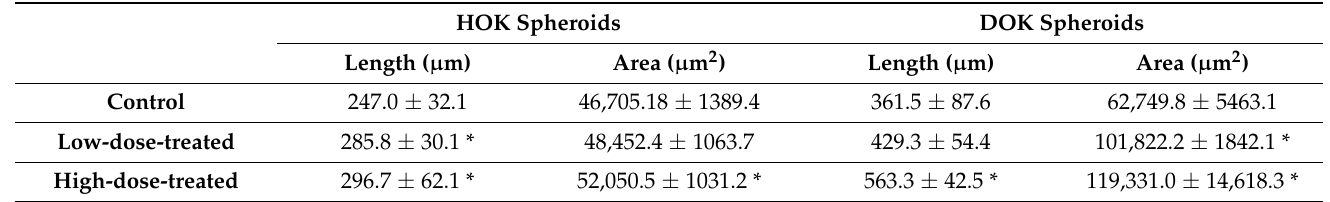
Figure 1. Size, viability, and invasiveness of HOK spheroids treated with the carcinogen 4NQO. ( a ) Representative images of HOK spheroids on days 1–8, treated daily for 90 min with low (0.36 µM) or high (0.72 µM) doses of 4NQO. Cells were plated in low-adherence plates at 20,000 cells per well, and media was changed daily. ( b ) Diameter of control and 4NQO-treated spheroids measured in µm. ( c ) Viability of control and 4NQO-treated spheroids assessed using APH assay (absorbance read at 405 nm). ( d ) Representative images of a Matrigel invasion assay using control and 4NQO-treated spheroids on days 0–4. ( e ) Invasiveness of 4NQO-treated spheroids as measured by the length of invasion (µm). ( f ) Invasiveness of 4NQO-treated spheroids as measured by area of invasion in µm 2 . All error bars are mean ± SEM, and significance is assessed as * p < 0.05. Table 1. Quantitative assessment of invasion of HOK and DOK spheroids treated with low and high doses of 4NQO using one-way